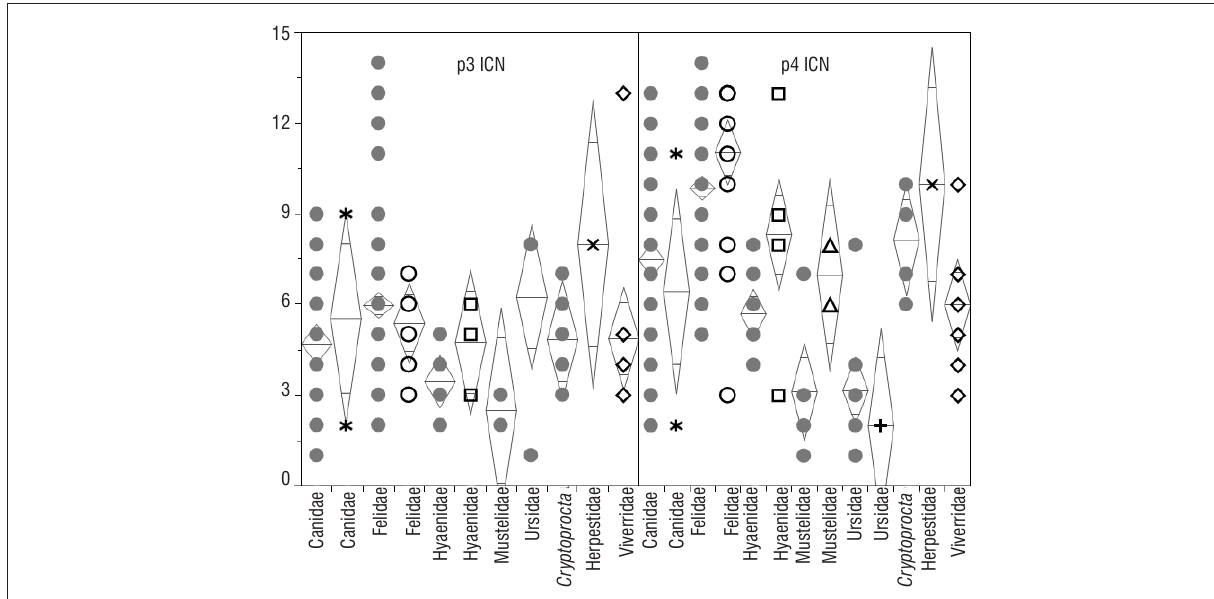
Extant taxa are represented by solid grey circles, Langebaanweg (LBW) canids are represented by asterisks, LBW felids by open circles, LBW hyaenids by open squares, LBW mustelids by open triangles, LBW ursids ( Agriotherium ) by ‘+’ signs, the single analysed LBW herpestid by an ‘x’ sign, and LBW viverrids by open diamonds. Each dotted diamond represents the mean and 95% confidence interval vertical span; the horizontal lines are the mean and ‘overlap marks’ that indicate statistical separation. Figure 8: Intercuspid notch (ICN) scores of the third (p3) and fourth (p4) lower premolars by family.